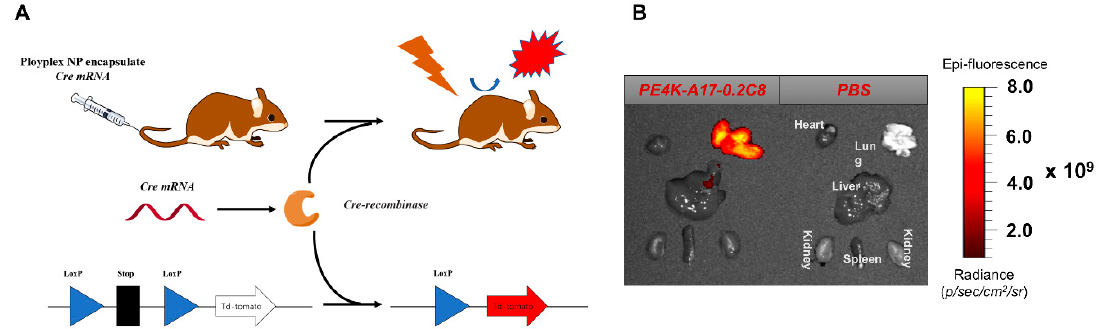
Figure 6. ( A ) TdTomato mouse model representation. ( B ) After I.V. injection of polyplex nanoparticles at a dosage of 0.5 mg/kg, tdTomato fluorescence was detected in lungs though ex vivo imaging.